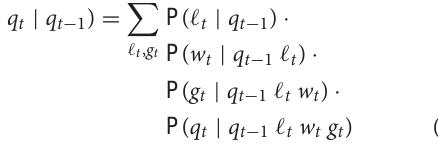
FIGURE 1 | Left-corner parser operations: (A) lexical match ( m ℓ and no-match ( m g